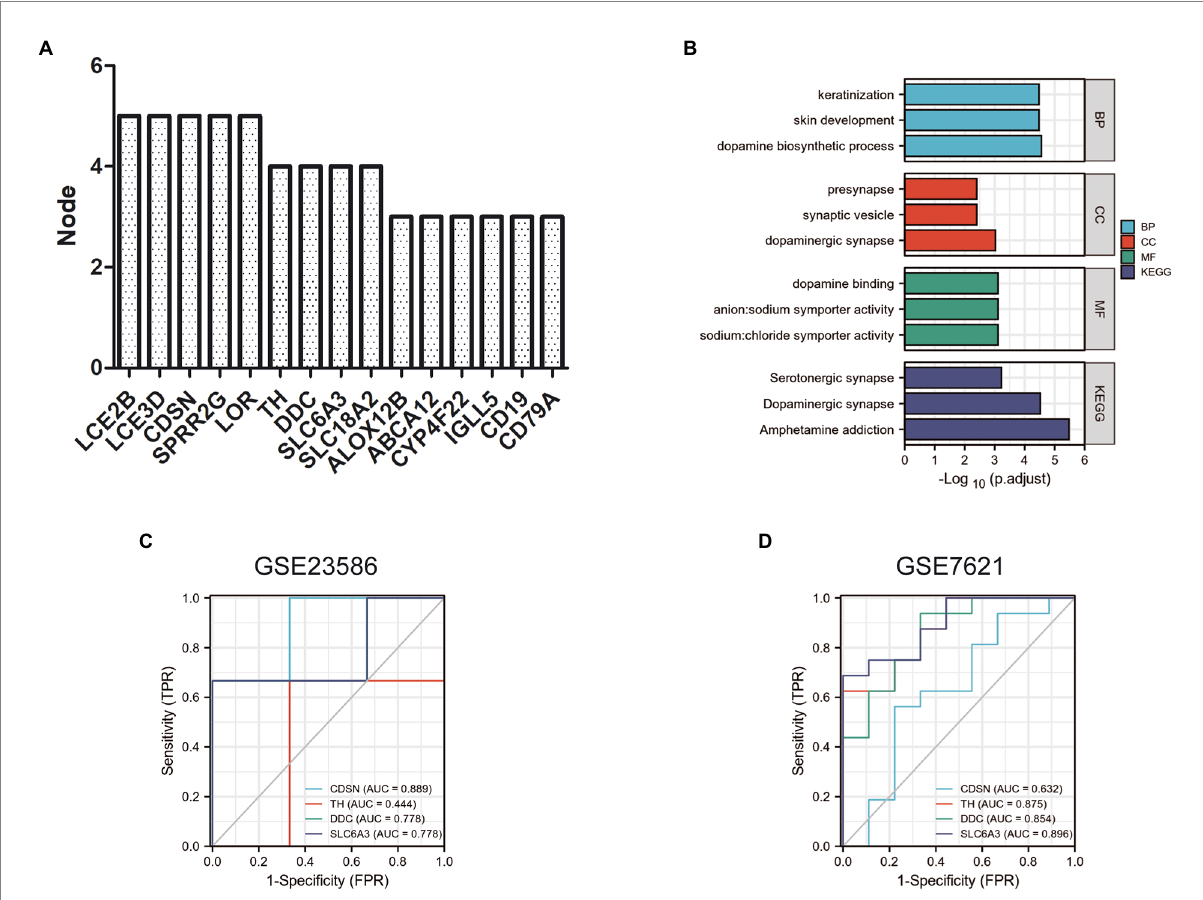
FIGURE 6 Functional enrichment analysis and ROC curve of hub genes. (A) Top 15 nodes of PPI networks of DEGs in GSE23586 and GSE7621 dataset. (B) GO and KEGG analysis of hub genes. Diagnostic value of 4 hub genes with ROC curves in GSE23586 dataset (C) and in GSE23586 dataset (D) . AUC area under the ROC curve.